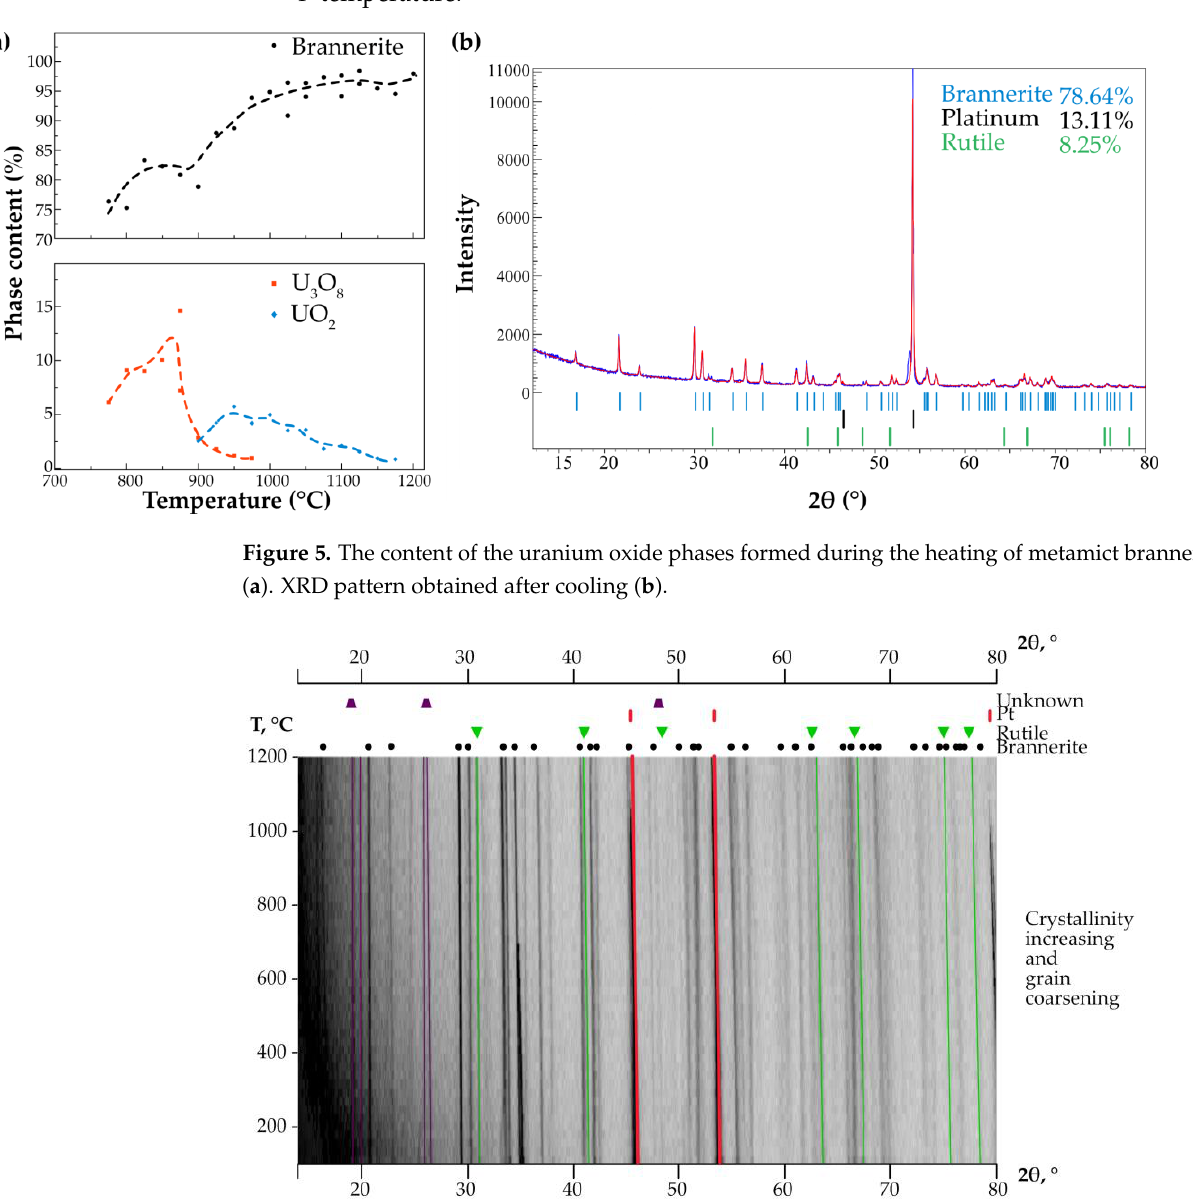
Figure 6. High-temperature XRD of the annealed brannerite. The admixture phases crystallized during the heating of the initial metamict brannerite are indicated above.